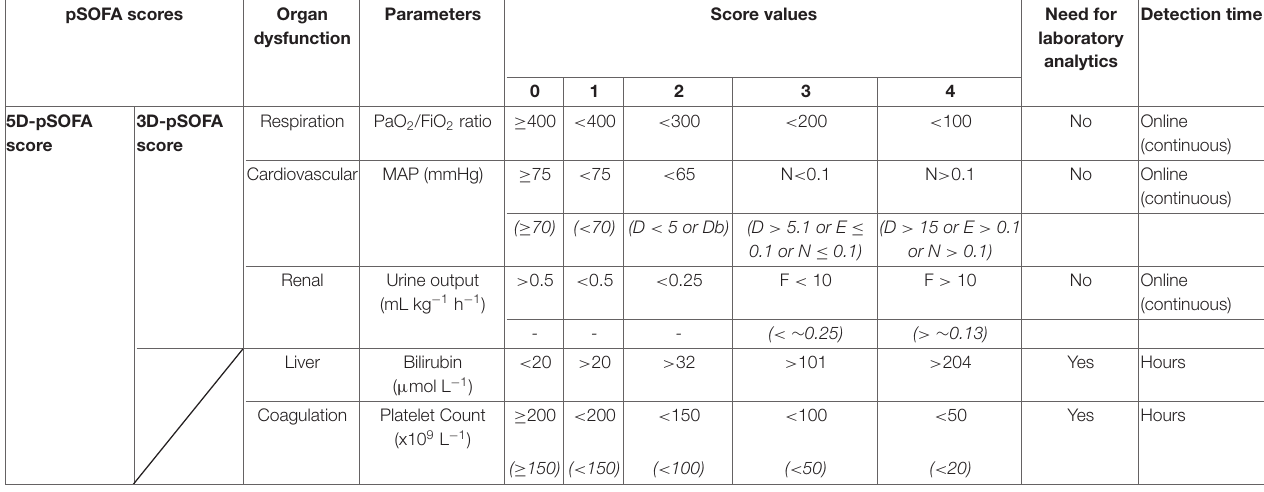
TABLE 1 | The pig-specific Sequential Organ Function Assessment (pSOFA) scoring system with 3 or 5 domains (3D-pSOFA and 5D-pSOFA scores) to assess sepsis-induced organ